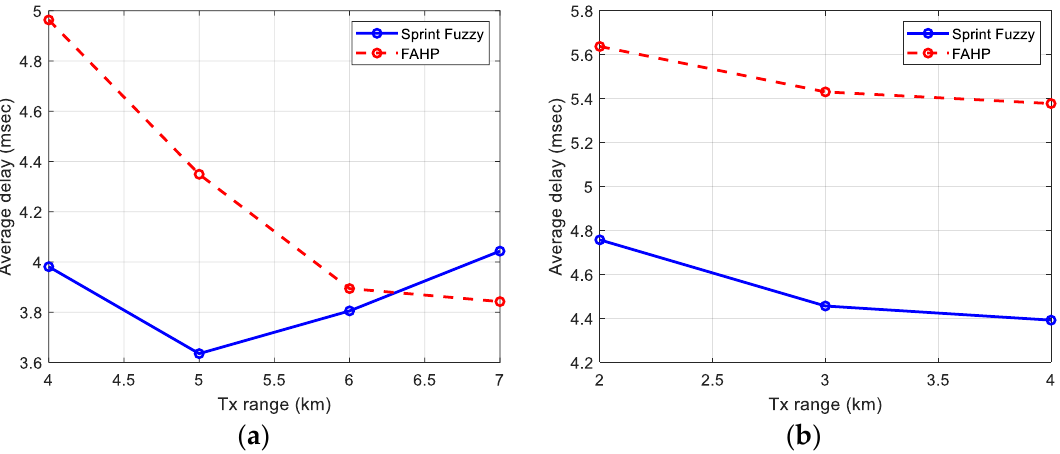
Figure 11. Average delay in reaching the gateway node. Number of nodes: ( a ) 100, ( b ) 400. Table 12. Statistical comparison for E2E packet delay.